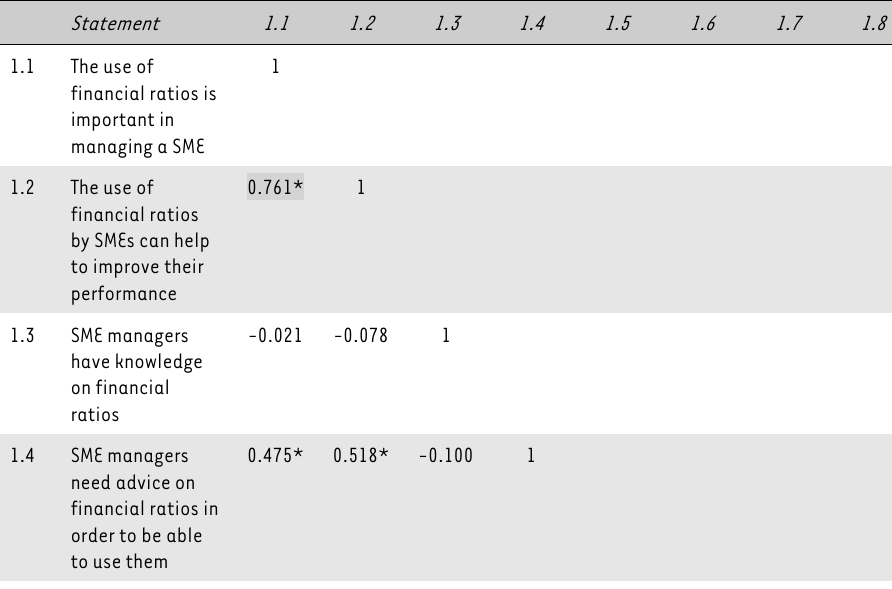
Spearman’s correlation coefficient: Financial